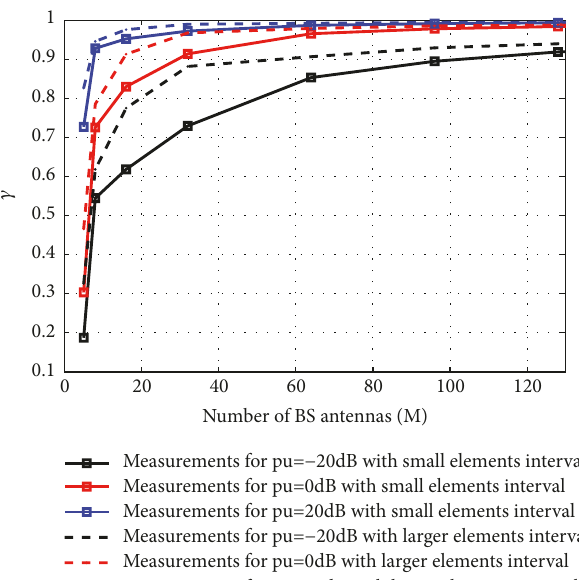
Measurements for pu=−20dB with small elements interval Measurements for pu=0dB with small elements interval Measurements for pu=20dB with small elements interval Measurements for pu=−20dB with larger elements interval Measurements for pu=0dB with larger elements interval Measurements for pu=20dB with larger elements interval Figure 6: Measurement result with different element spacing.